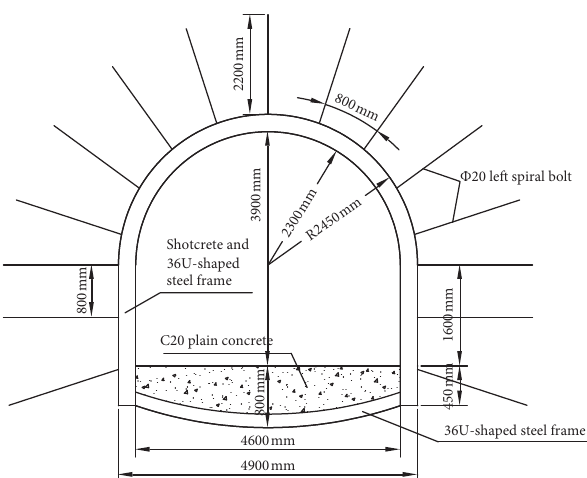
Figure 1: Original supporting design of rail